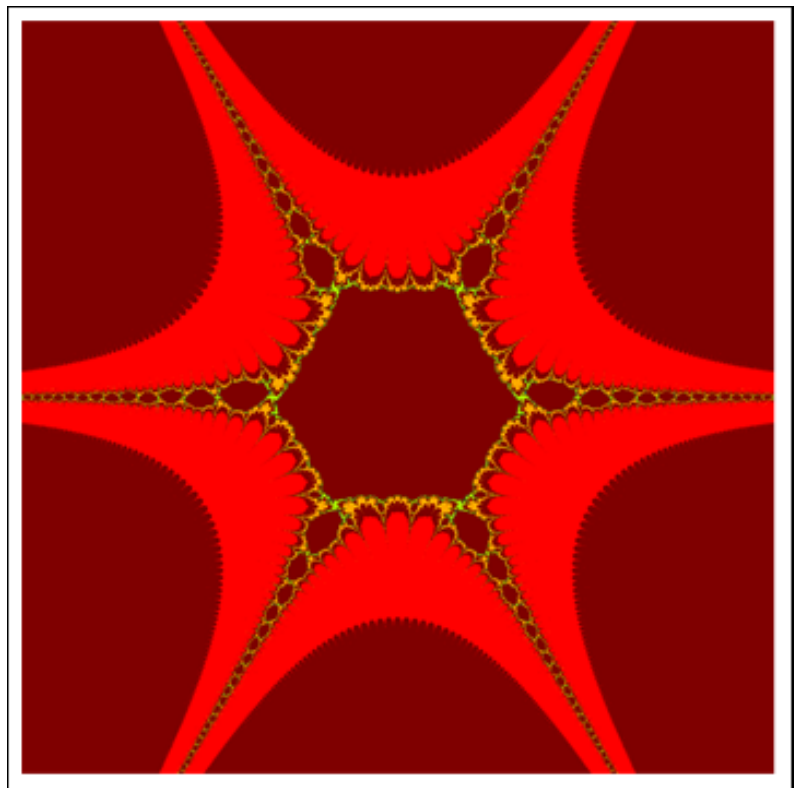
Figure 2. J-set for τ ( z ) = sin ( z 3 ) + c via DKIS. The image execution time is 1214.31 s.